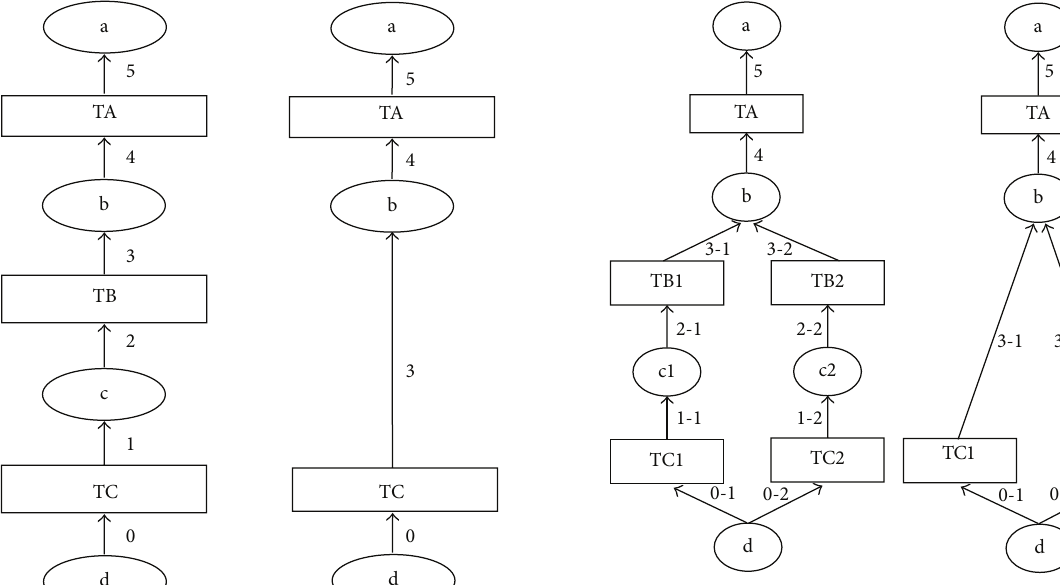
Figure 8: Reduction of fork and joint structure model